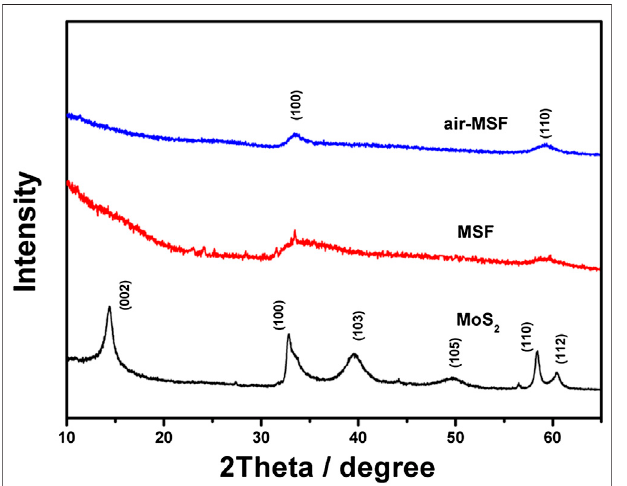
FIGURE 6 | Electrochemical impedance spectra of DSSCs with air- mesoporous silica nano fi ber (MSF), MSF, MoS 2 , and Pt counter electrodes. Inset displays the corresponding equivalent circuit.